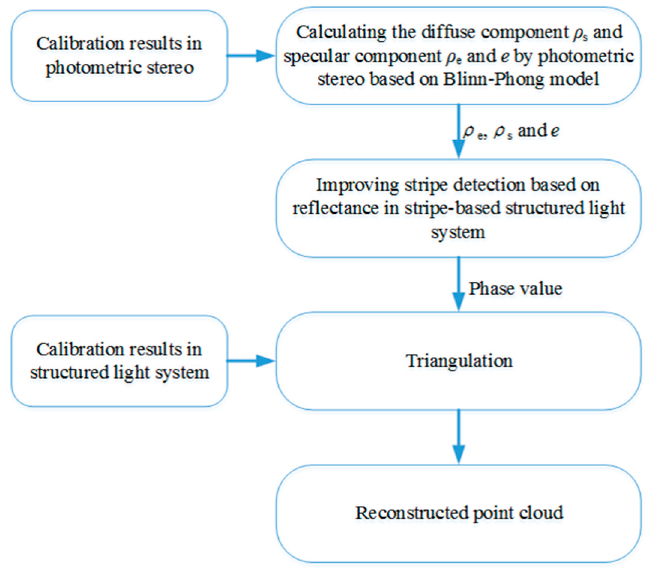
Figure 1. Flowchart of the proposed 3D measurement system.